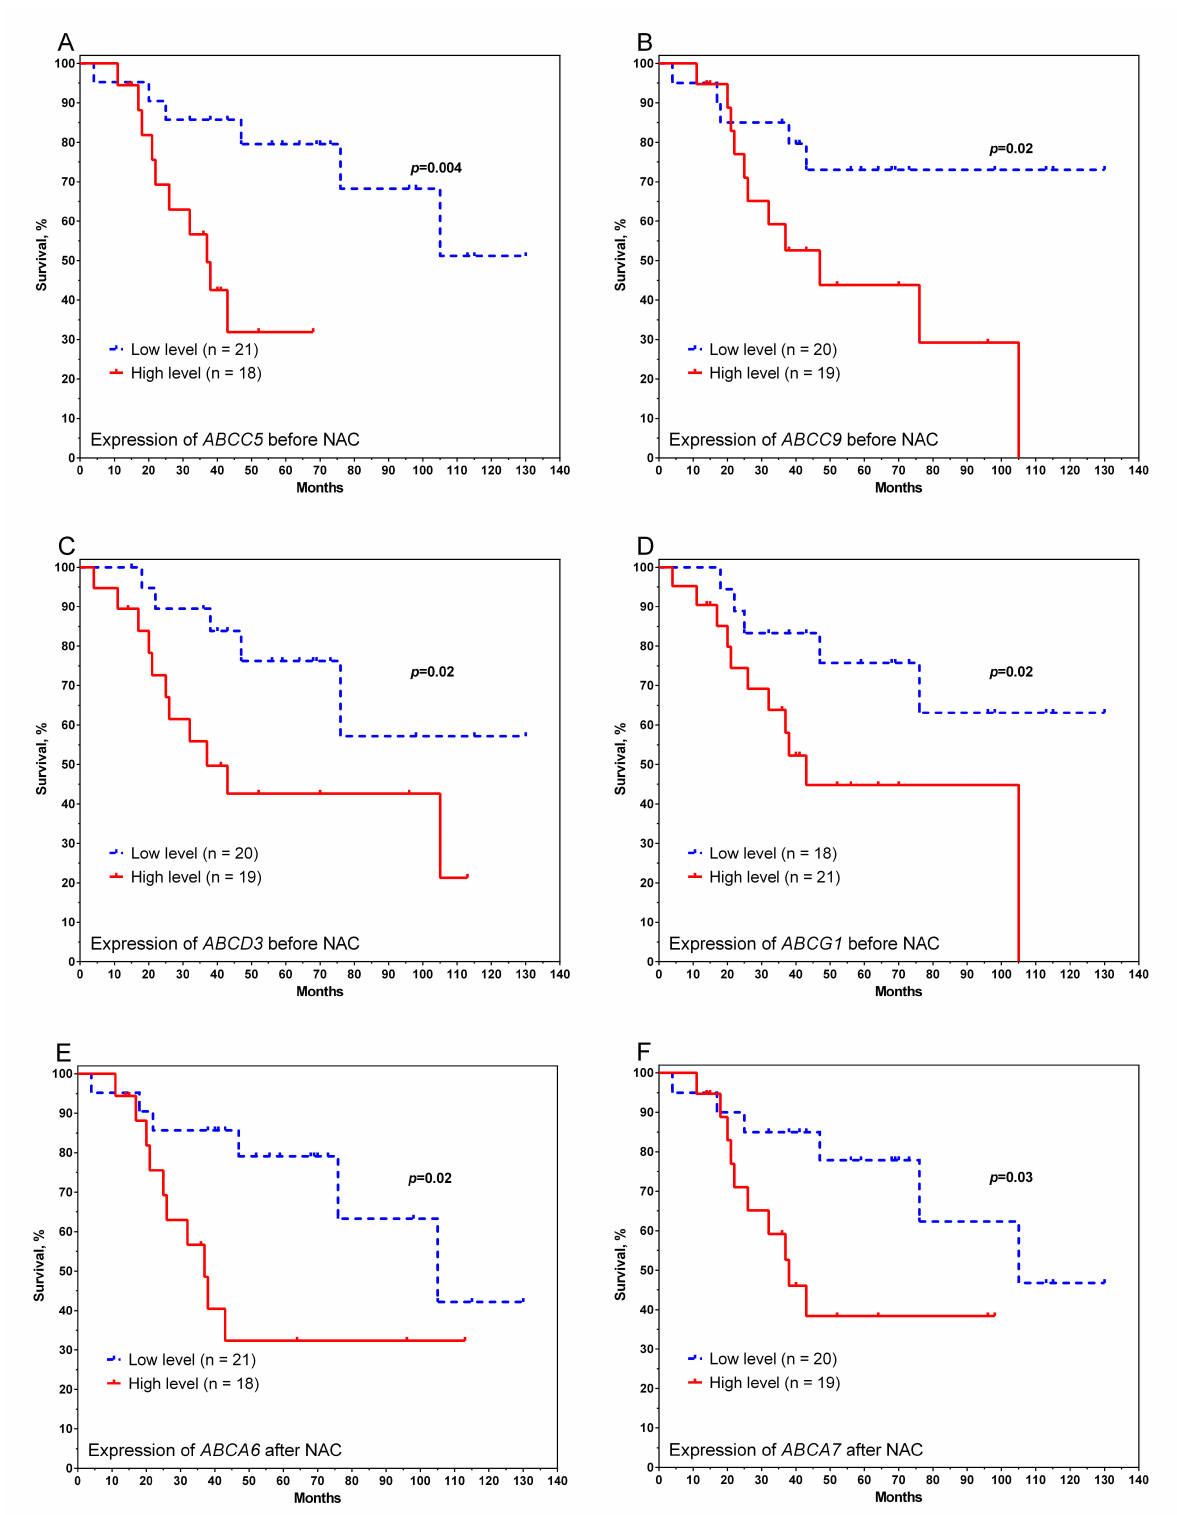
Figure 3. Curves of metastatic survival of breast cancer patients depending on the initial level of expression of genes ABCC5 ( A ), ABCC9 ( B ), ABCD3 ( C ), and ABCG1 ( D ), as well as the postoperative level of expression of genes ABCA6 ( E ) and ABCA7 ( F ). Note: the median of expression was used as a grouping variable: for ABCC5 , 8.28; ABCC9, 7.46; ABCD3 , 6.73; ABCG1 , 8.32; ABCA6 , 6.35; ABCA7 ,